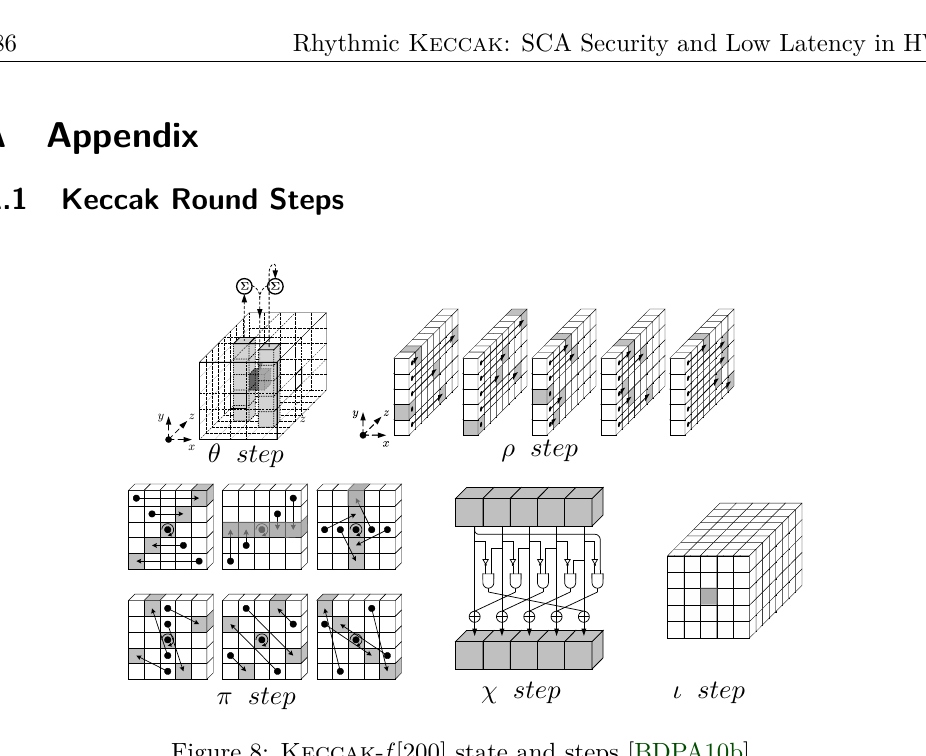
Figure 8: Keccak - f [200] state and steps